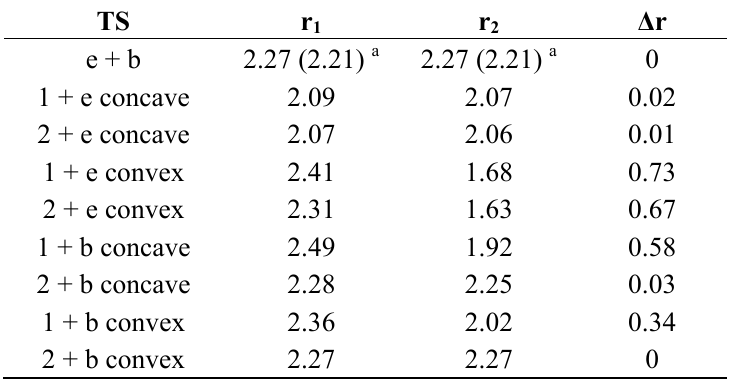
and r , in Å, for the transition states shown in Figure 5. Also Δ r = r 1 2